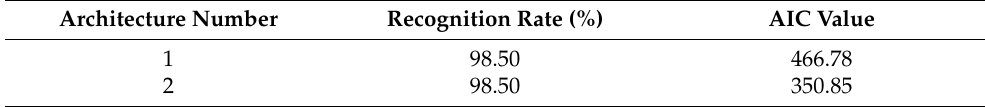
Table 4. Objective function values based on the recognition rate and the AIC